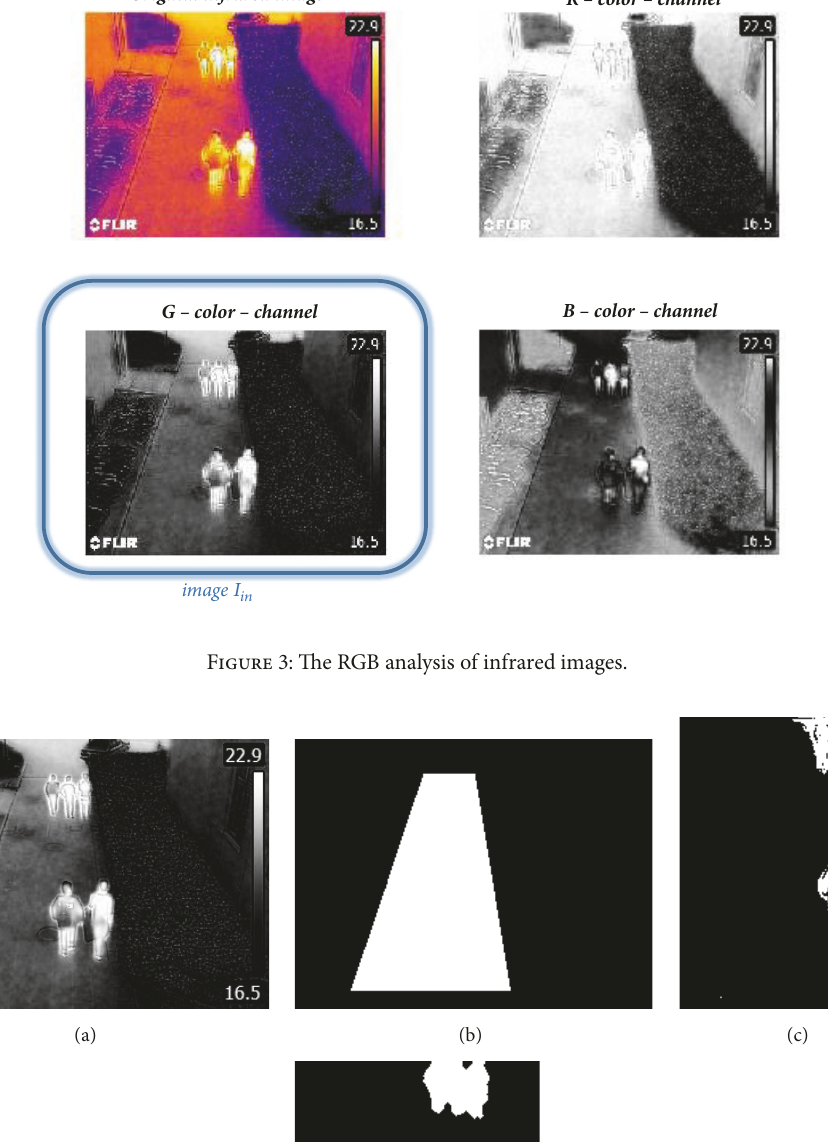
(1) Area 𝐴 𝑘 , which is the weighted sum of all pixels in the blob,